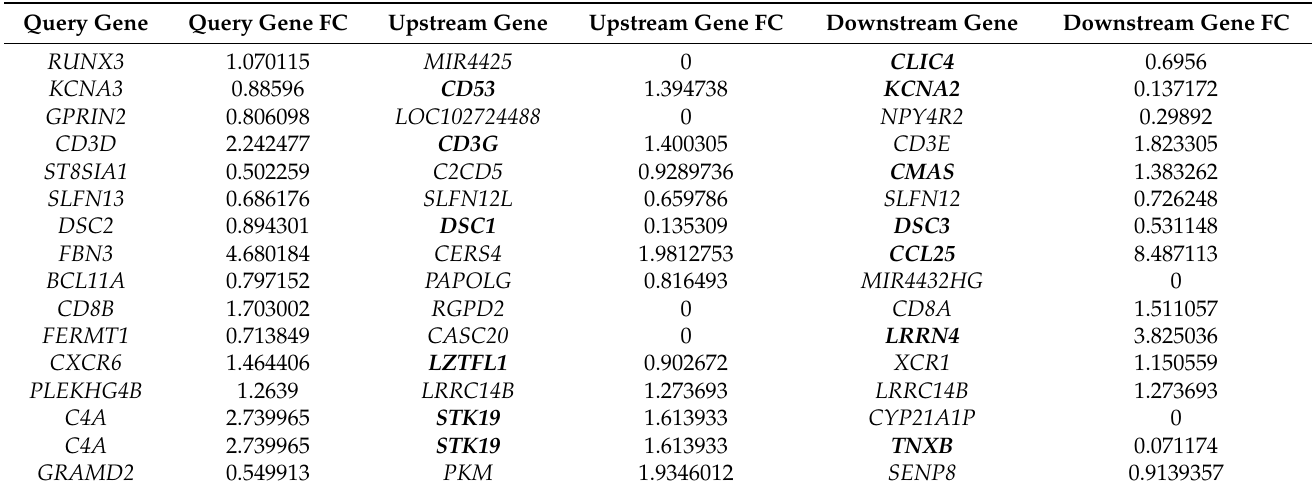
Table 6. Average expression of closest upstream and downstream genes of selected female-biased genes in BC. Query Gene Query Gene